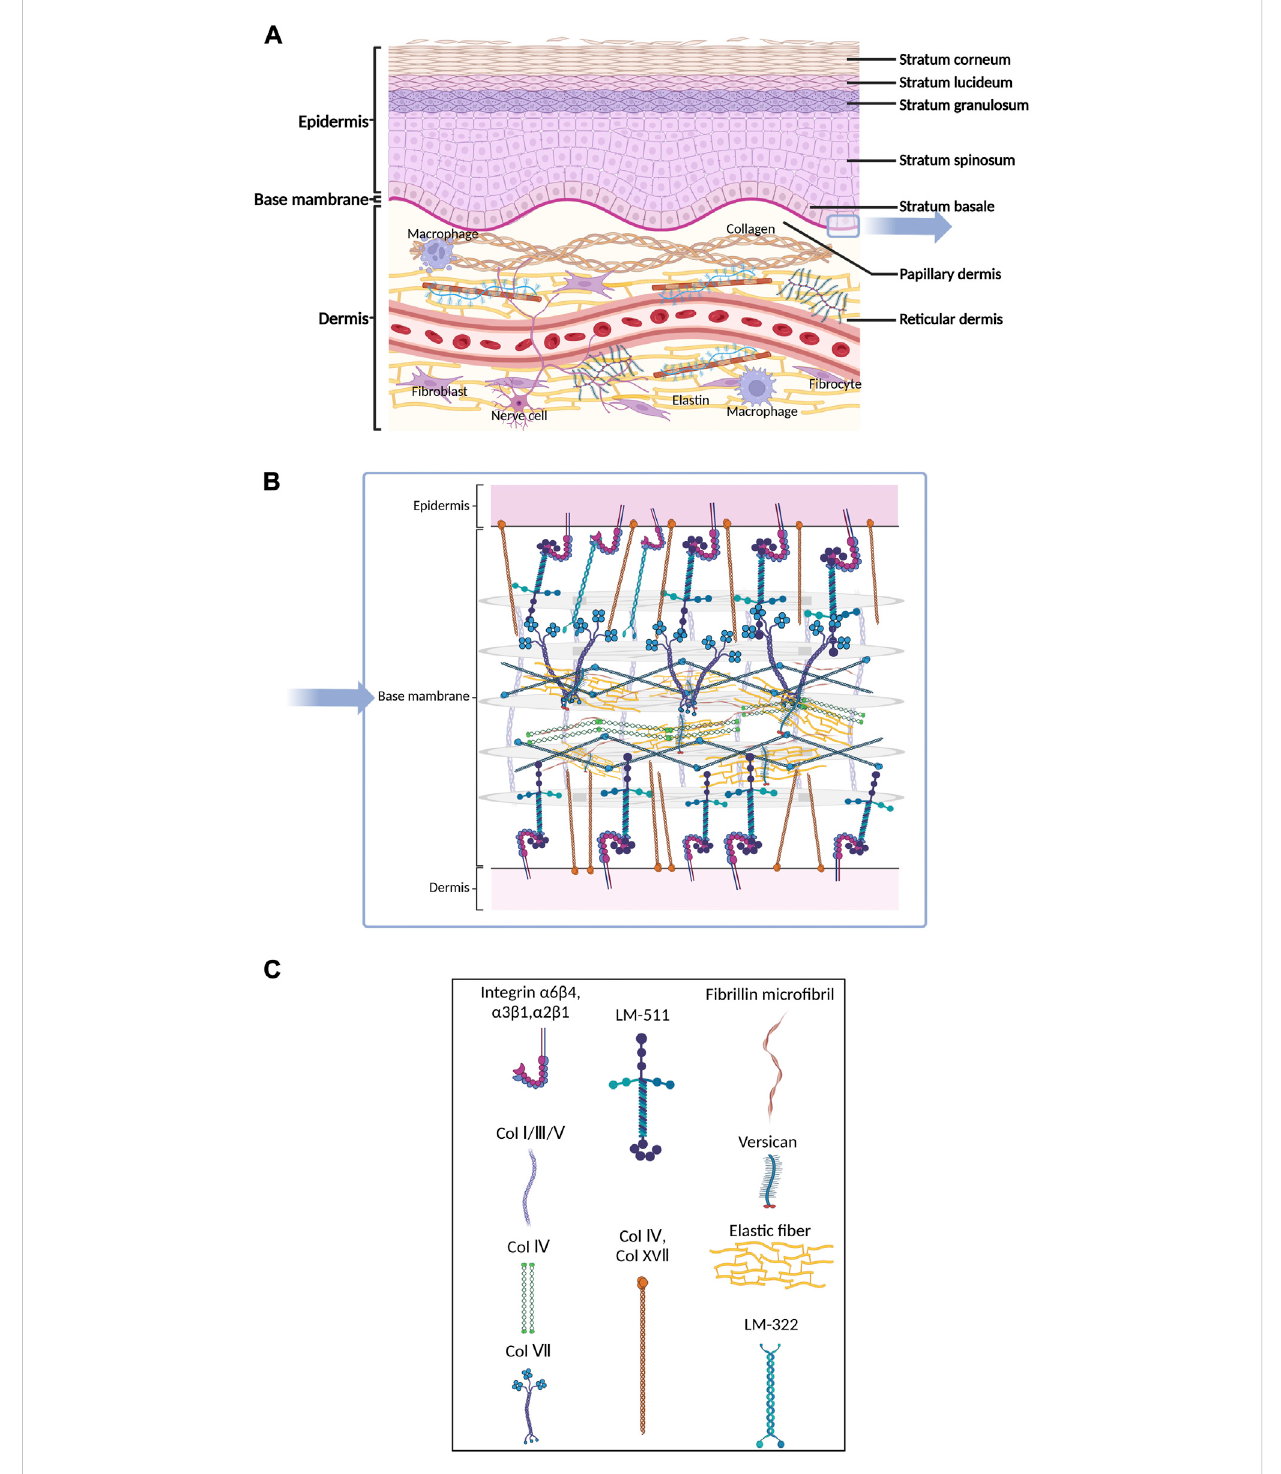
FIGURE 2 Schematic of skin histology viewed in cross-section. Three layers of mammalian skin: epidermis, basement membrane and dermis. (A) The epidermis contains corneocytes on the surface and keratinocytes in various developmental stages. The ECM molecules include GAG, hyaluronic acid, heparansulfate,chondroitinsulfateandvariouskindsofextracellularlipids.Thedermisconsistsofbloodvesselsandnerves.Manykindsofcells,including fi broblasts and macrophages, participate in the process of fi brosis. (B) and (C) The basement membrane is composed of individual laminin and collagen type IV, which provide mechanical connections between the epidermis and